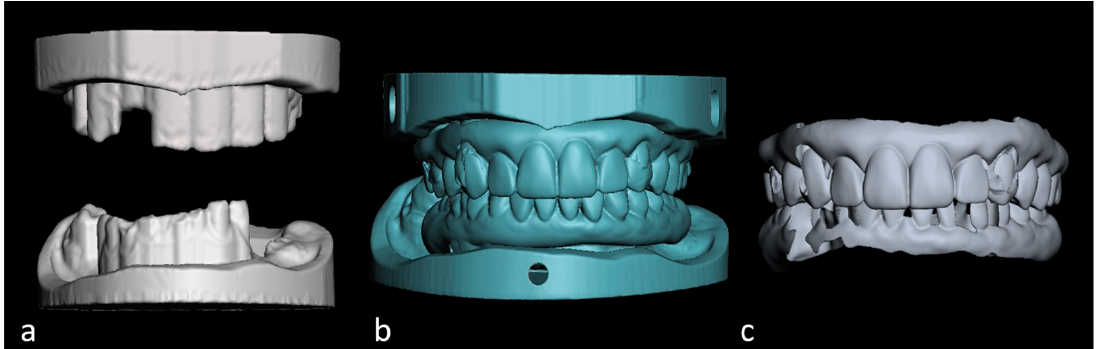
Figure 7. Modeling of the gingival horseshoe and digital teeth. ( a ) Gingival horseshoe positioned on the blocked-out model. ( b ) Digital tooth arrangements previously set in the models at the desired vertical dimension of occlusion. ( c ) Digital design of maxillary overlay after minor modifications.